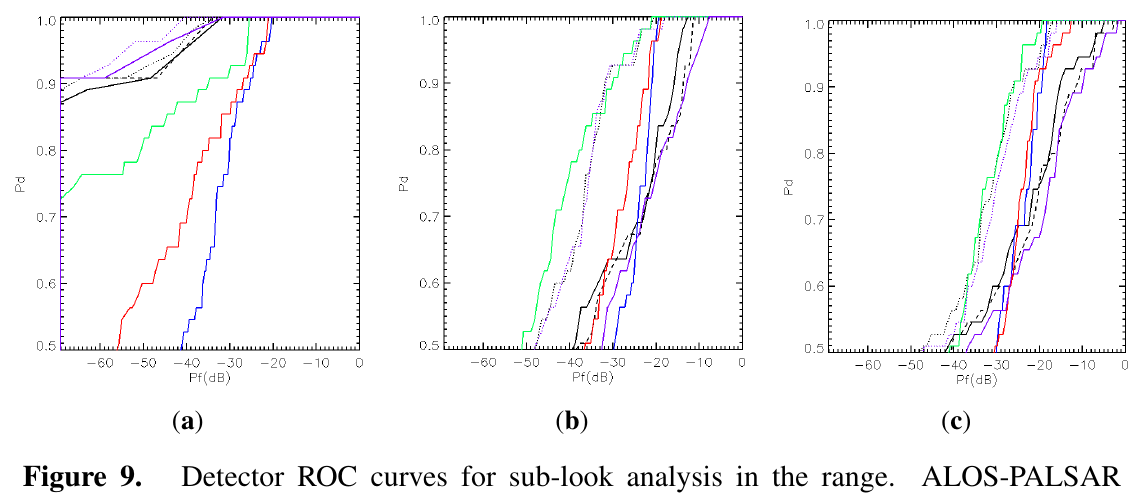
Figure 9. Detector ROC curves for sub-look analysis in the range. ALOS-PALSAR quad-polarimetric data. Boxcar filter: 3 × 15 (range × azimuth) pixels. ( a ) HV channel; ( b ) HH channel; ( c ) VV channel. Vessels analyzed: 53; pixels used for P sub-look correlation (solid: filtered with no overlap; dashed: filtered 30% overlap); blue: sub-look coherence; green: GLRT; violet: intensity (dotted: no average; solid: averaged); red: sub-look